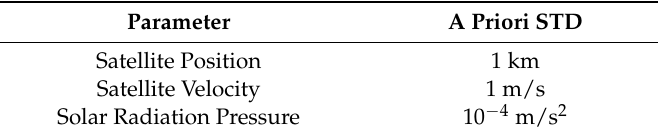
Table 5. A priori STD of initial